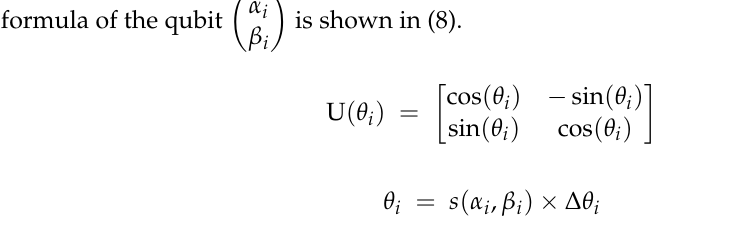
Figure 7. Rotation direction of rotation gate.